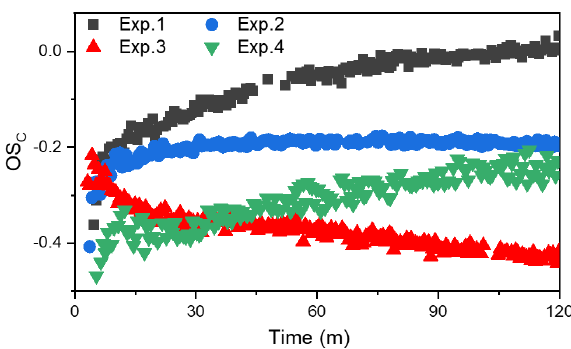
Figure 2. The OS C values for the toluene SOA formed under dif- ferent NH 3 / NO x